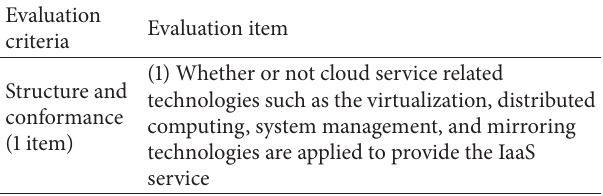
Table 8: Evaluation items of structure and conformance of